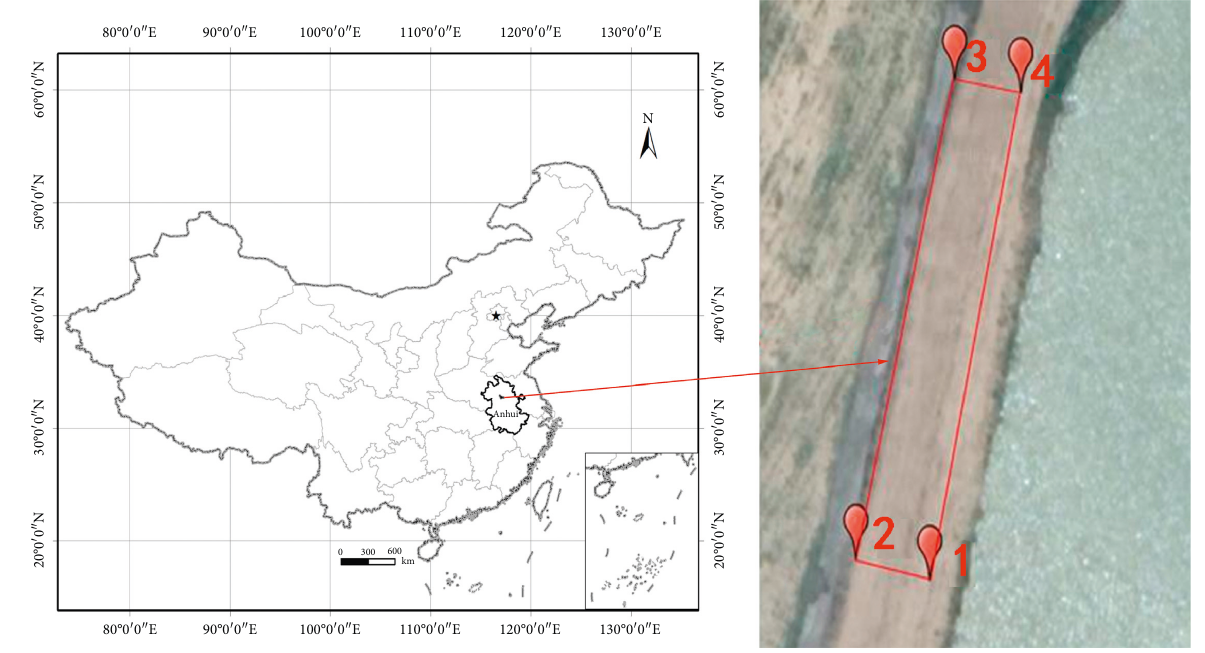
Figure 1: The location of experiment site. Table 1: Selected chemical and physical properties of topsoil, subsoil, and coal gangue.